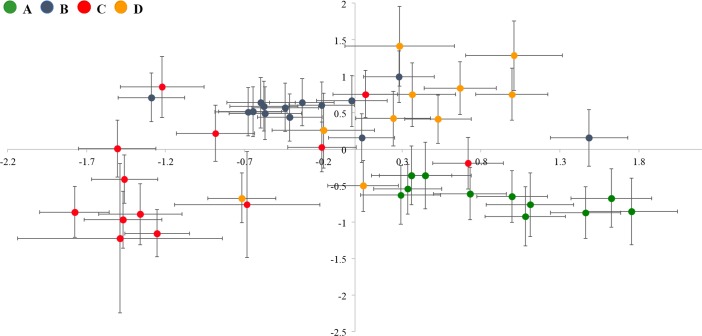
Analysis of the association between molecular species delimitation and morphometry.Representation of sample score averages of each of the studied clones along the first two axes (axis x: PC1, axis y: PC2) of the principal components analysis (PC1 explained 57.67% and PC2 explained 14.74% of the recorded variation) performed on standardized morphometric data. Error bars represent variation between individuals of the same clone (twice the standard error of the mean).